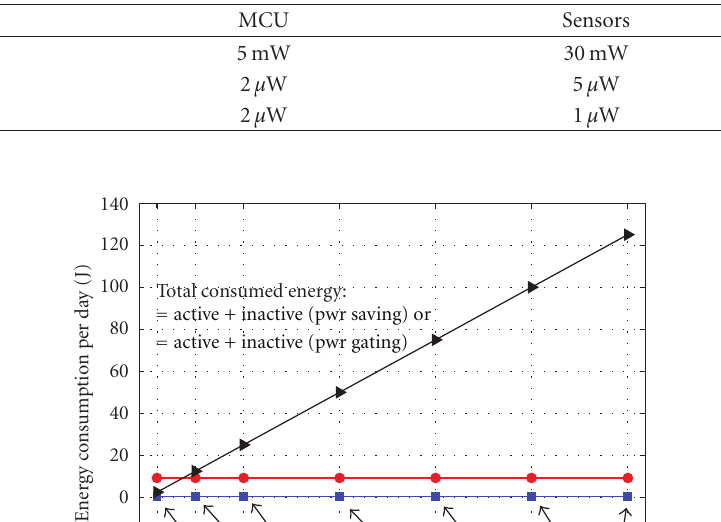
Table 1: Typical power profile for a WSN node.